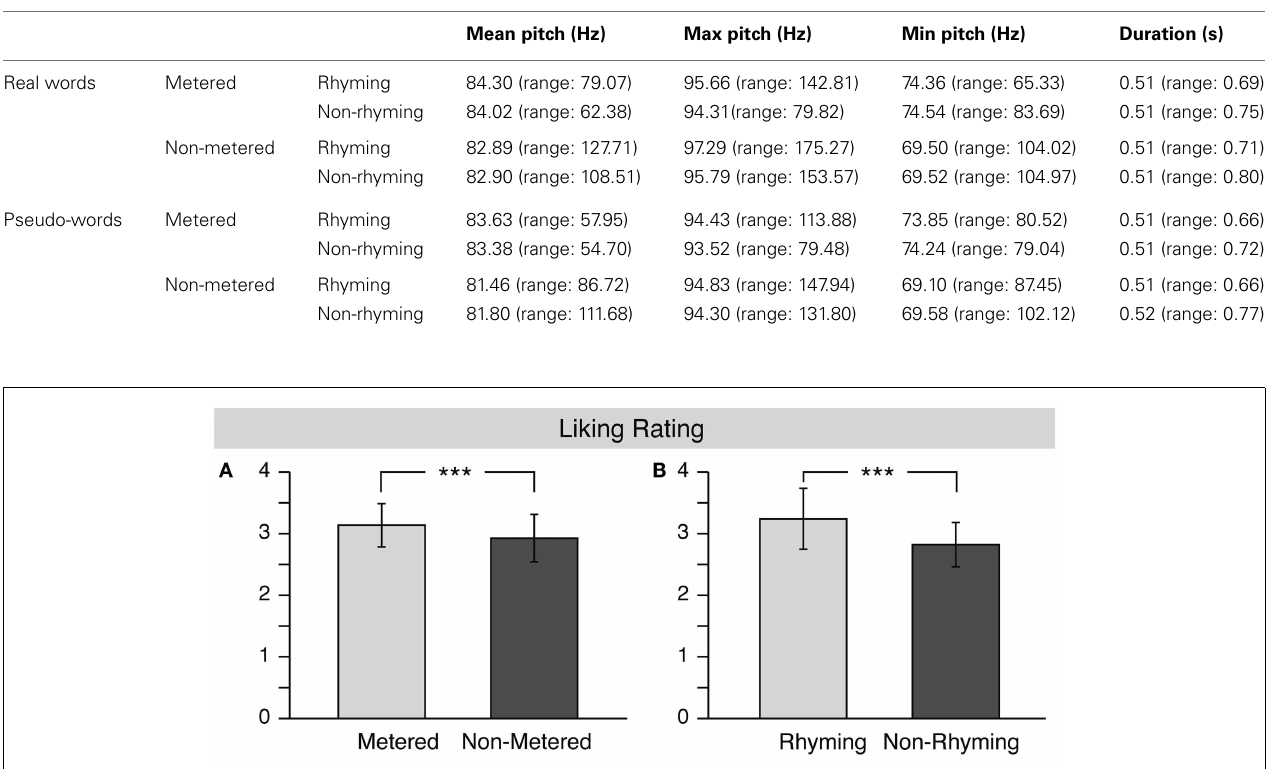
Table 3 | Statistical values (mean, range) across the critical, final words of each line for all stimulus